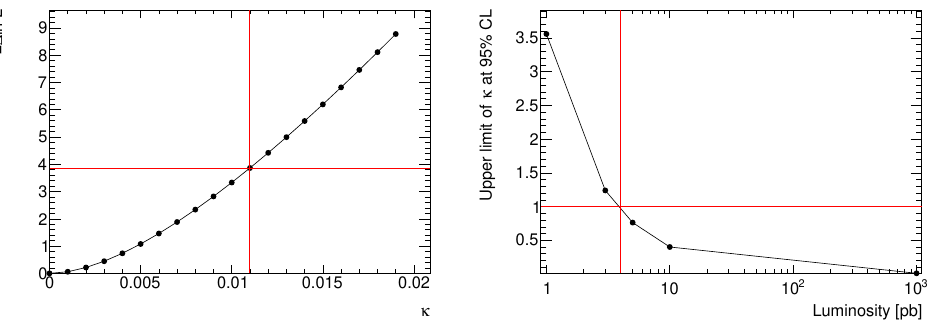
Figure 9 . Left: the − 2∆ ln L as a function of κ for a luminosity of 1 fb − 1 . The red lines indicate the interval at 95% confidence level. Right: the upper limit of κ at 95% confidence level as a function of the luminosity. The red lines indicate the luminosity corresponding to the upper limit of κ being